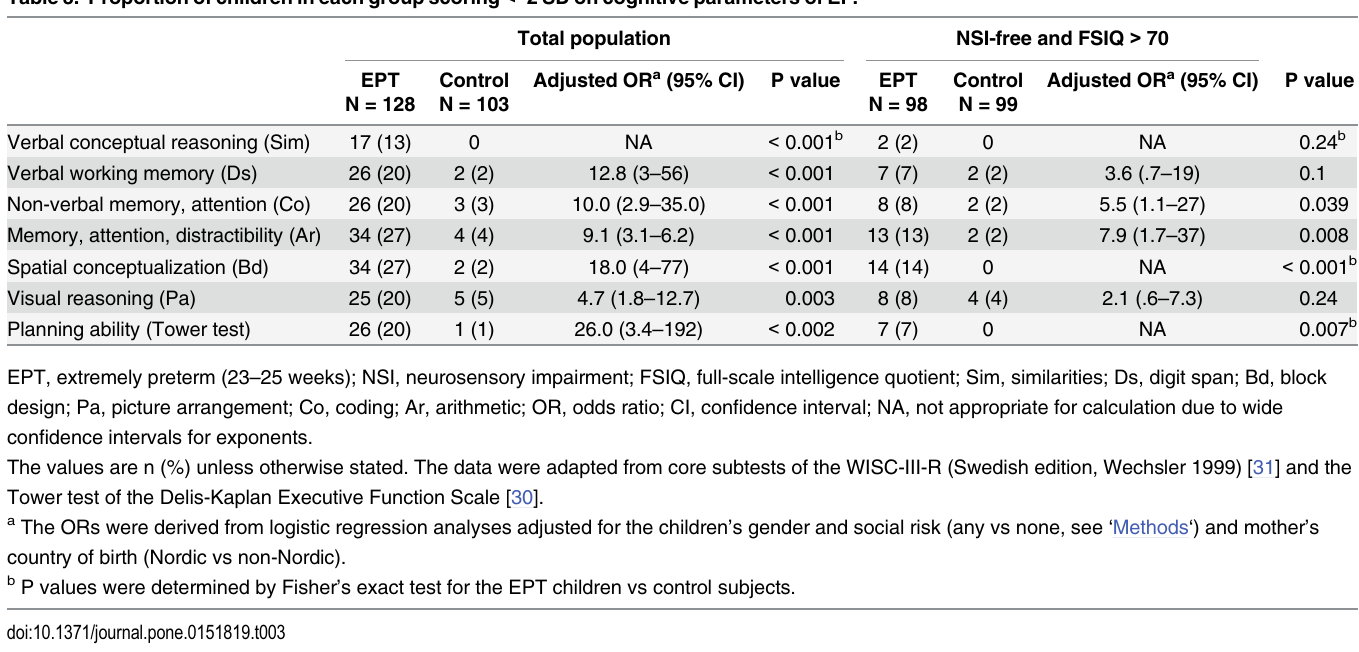
Table 3. Proportion of children in each group scoring < -2 SD on cognitive parameters of EF.